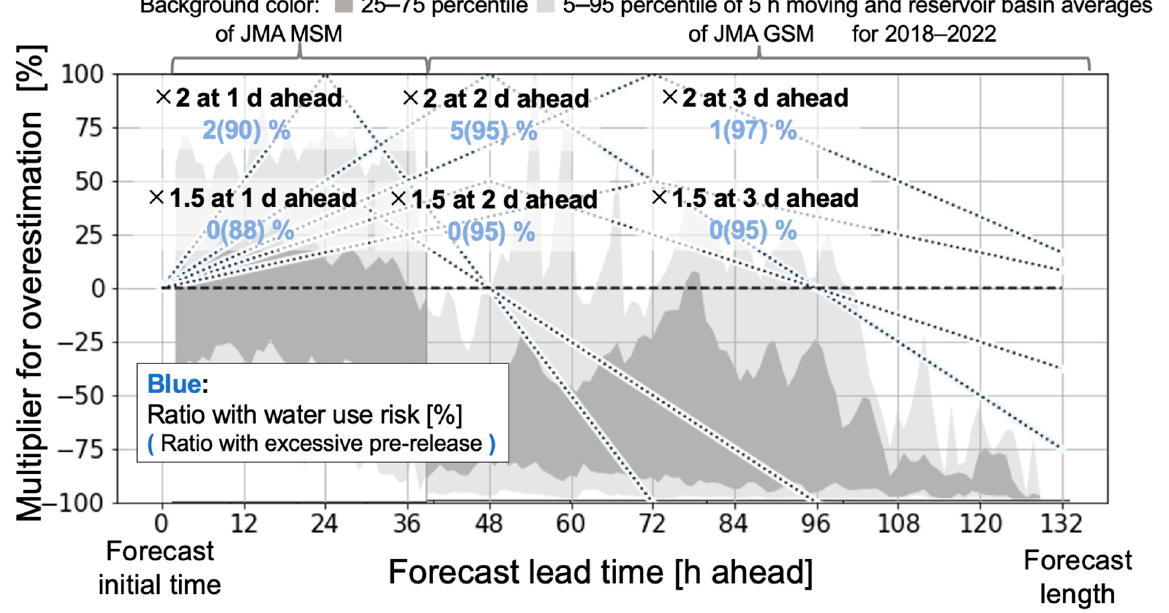
Figure 19. Another version of Figure 18 shown on the forecast pa tt erns’ variations. Ratio ( %) of cases with water use risk when using overestimated rainfall forecasts for all pre-release and quasi-pre-release cases. 5 h moving and reservoir basin averages of JMA’s rainfall forecast (MSM –39 h/GSM 40 h–) is represented in background color: gray for the 25–75 percentile and light gray for the 5–95 percentile.